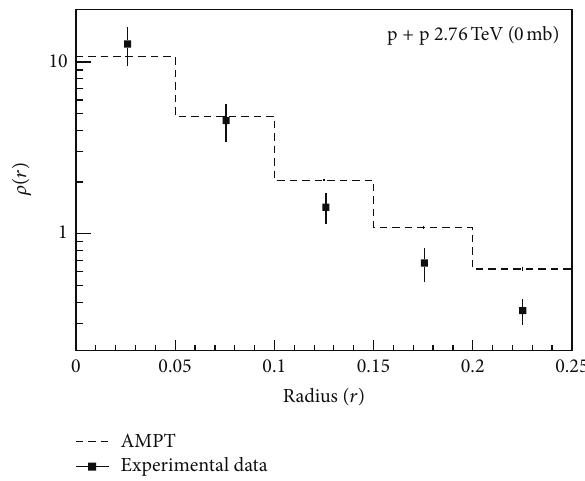
Figure 8: The differential jet shapes 𝜌(𝑟) in p + p collisions at √𝑠 = 2.76 TeV, where the histogram represents the AMPT result 𝑁𝑁 with hadronic interactions only and the squares represent the data from the CMS experiment [14,